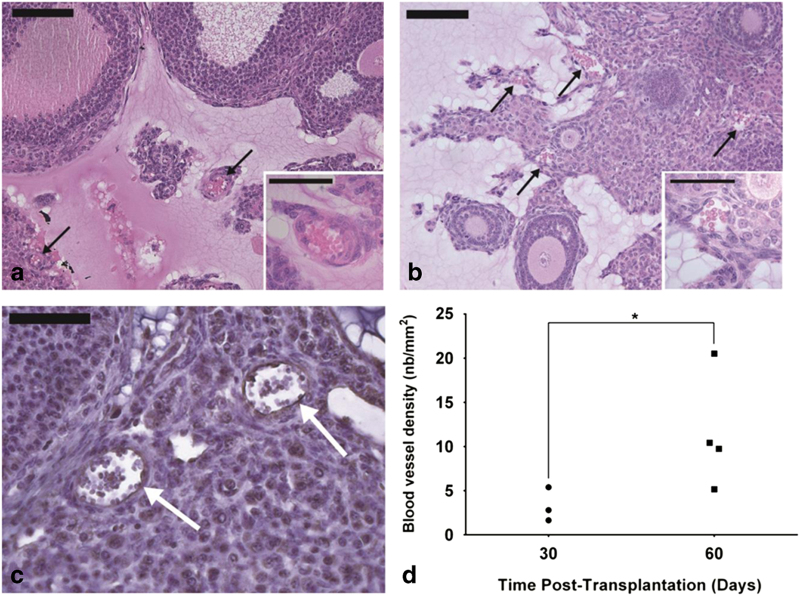
Graft remodelling and revascularisation. Functioning blood vessels (arrows) were found after (a) 30 days and (b) 60 days in vivo, as indicated by the presence of red blood cells (box). Scale Bar=100 μm, box: 50 μm (c) CD34 staining (arrows) confirmed the infiltration of blood capillaries into the graft. (d) Blood vessel density (number of blood vessel (nb) per mm2) significantly increased from 30 days to 60 days post-Tx, confirming more progressed remodelling process. Neovascularisation was observed in three out of five mice for 30 days post-Tx and four of five mice for 60 days. Statistical significance was determined by the Mann–Whitney test (P=0.1).